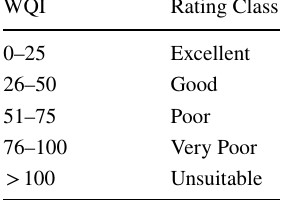
Source: Brown et al. (1972), Chatterjee